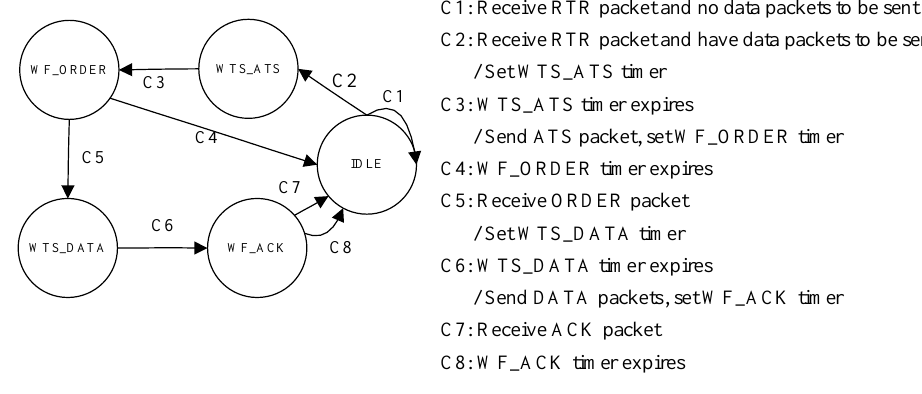
Figure 4. The state transition diagram of level-1 node in the RSV-MAC protocol.